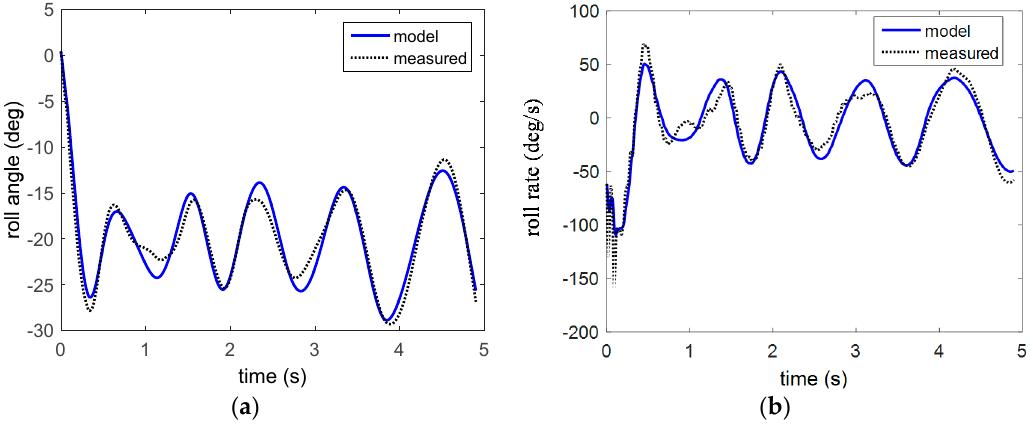
Figure 30. Modelled roll angle ( a ) and roll rate ( b ) versus the measured data for second analysis period.